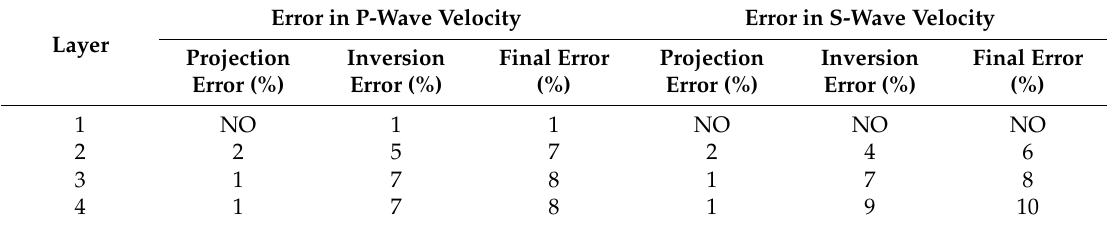
Table 1. Percentage errors of P-wave and S-wave velocities estimated from the sensitivity analysis. Error in P-Wave Velocity Error in S-Wave Velocity Layer Projection Inversion Final Error Projection Inversion Final Error Error (%) Error (%) (%) Error (%) Error (%) (%) NO NO